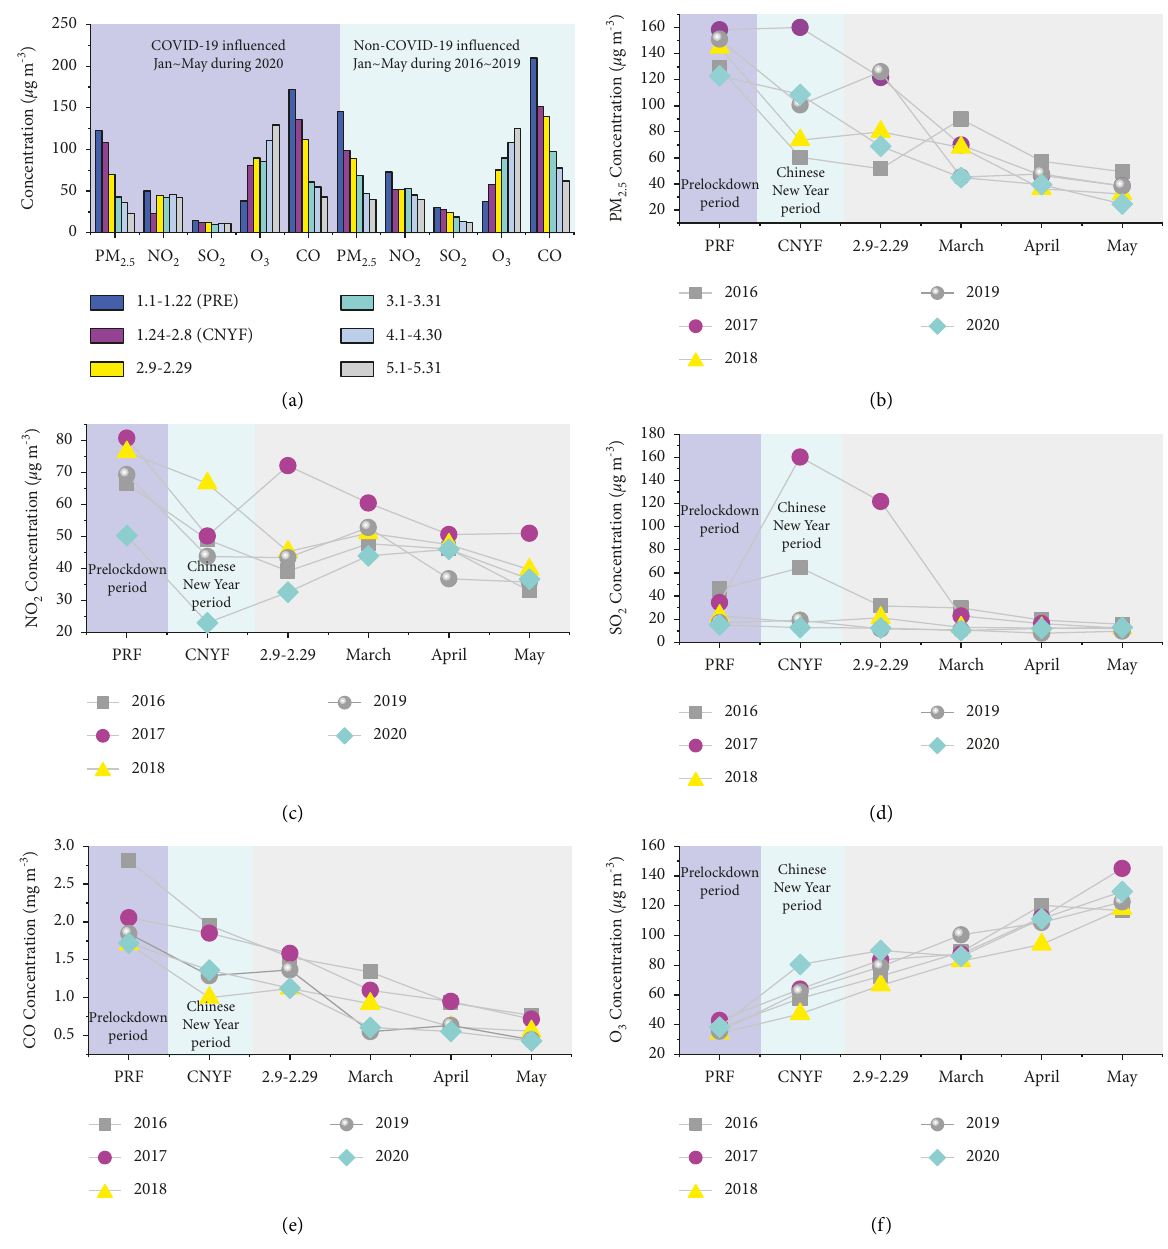
Figure 4: Comparison of the concentration trends of PM 2.5 , NO 2 , SO 2 , CO, and O 3 in 2020 and the historical concentration trends (2016–2019). PRF represents the prelockdown period; CNYF represents the Chinese New